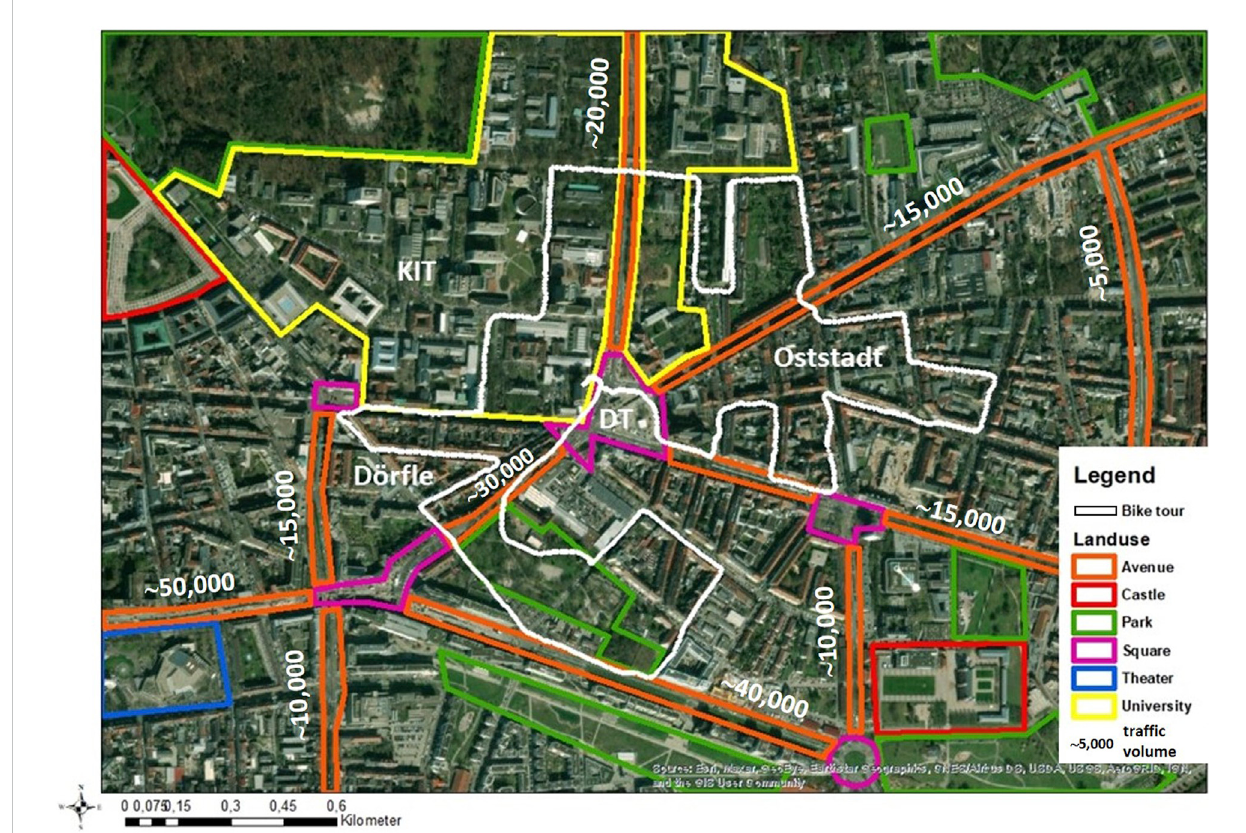
Land use patterns in eastern inner city of Karlsruhe and pathway of aerosol recording by a bike trailer based sensor system (the central square is the Durlacher Tor (DT)). Average daily traf fi c volume for 2019 is based on data from Stadt Karlsruhe. (2013) ( ” ~5000 ” in the legend is provided as an example).